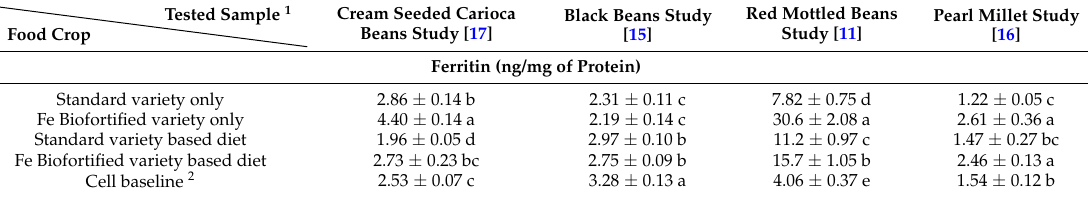
Table 5. Ferritin concentration in Caco-2 cells exposed to samples on the tested staple crop only (whole seed), and the crop based